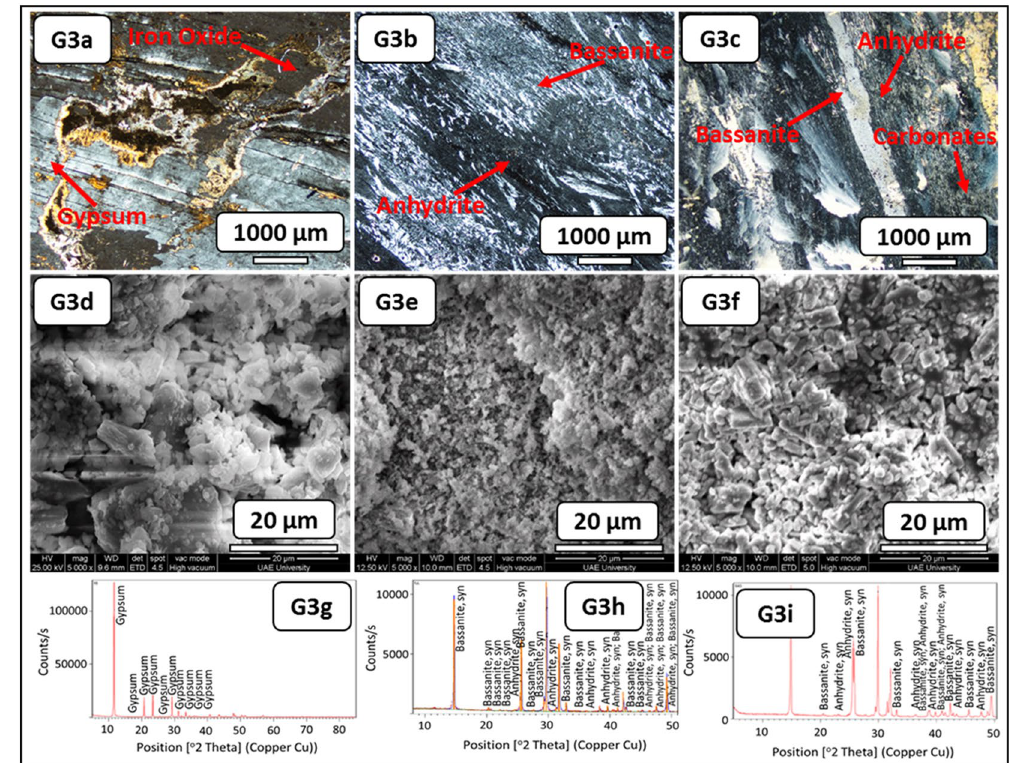
Figure 9. Microscopic description, SEM and XRD of an evaporitic rock Group 3 (fresh sample, after slaking with distilled water and groundwater respectively). G3a–G3c represents thin section images under cross- polarized microscope showing mega- bladed crystals of gypsum with iron oxides patches before SDI and fibro- radiating bassanite intergrowth with microcrystalline anhydrite with trace carbonate after SDI test. G3–-G3f. represents SEM images showing prismatic gypsum crystals and needle shaped before SDI with interspersed in a loose fabric of bassanite and anhydrite after SDI test. G3g-G3i represents XRD analyses showing richness of gypsum before SDI test where after SDI bassanite is mainly dominant than